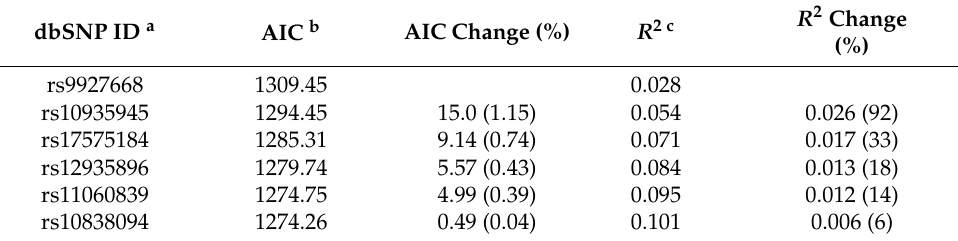
Table 3. The results of the stepwise selection for the logistic regression model. dbSNP ID